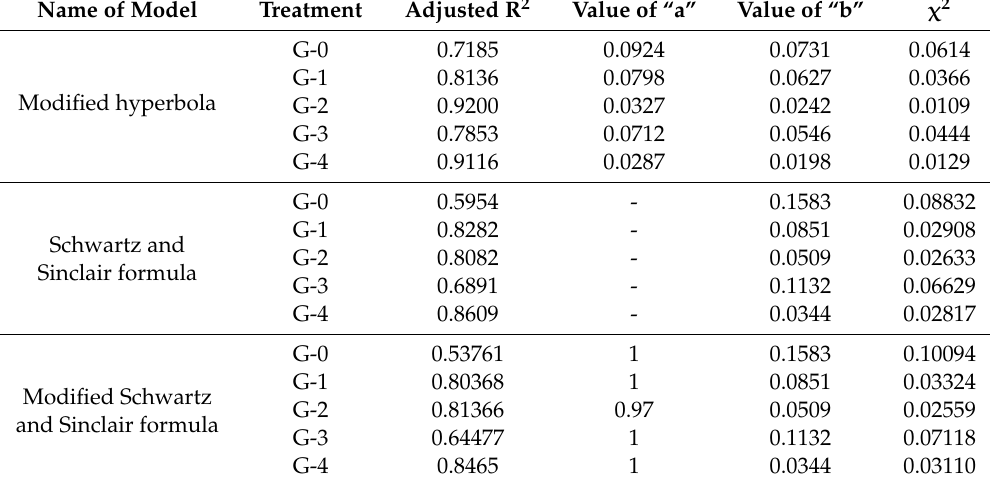
Table 2. Release kinetics of uncoated and coated granular urea at 25 ºC calculated by using three di ff erent model equations.